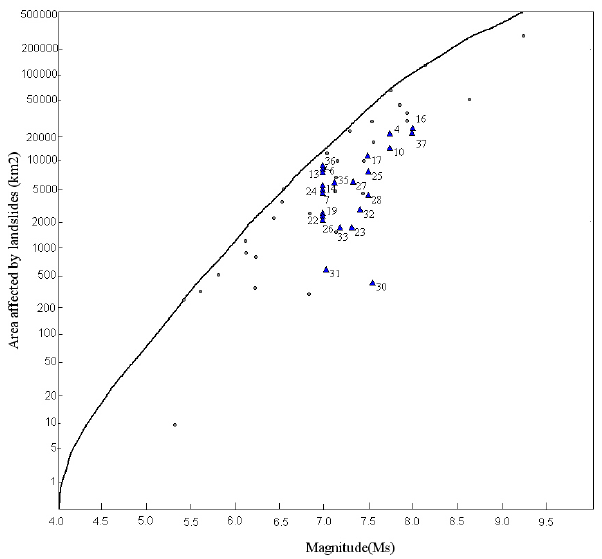
Fig. 8. Areas affected by landslides triggered by earthquakes with magnitude ≥ 7.0 in southwest China as a function of magnitude. Upper bound line and dots are from Keefer (1984). The triangles and numbers refer to the identification of individual events in Table 1.